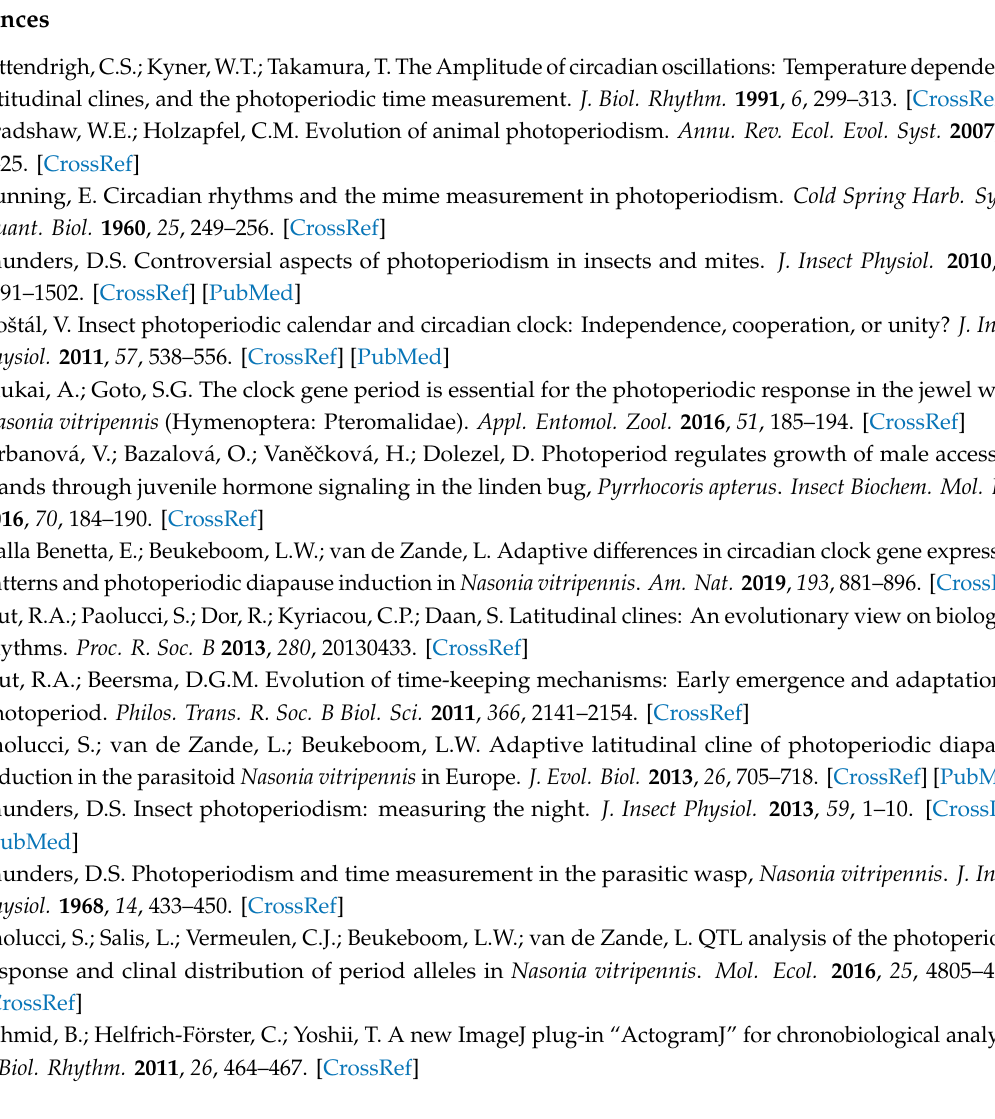
Table S1: Statistical analysis of circadian timing under LD 16:08, Table S2: Statistical analysis of circadian timing under LD 08:16, Figure S1: Correlation between peak of activity and free running